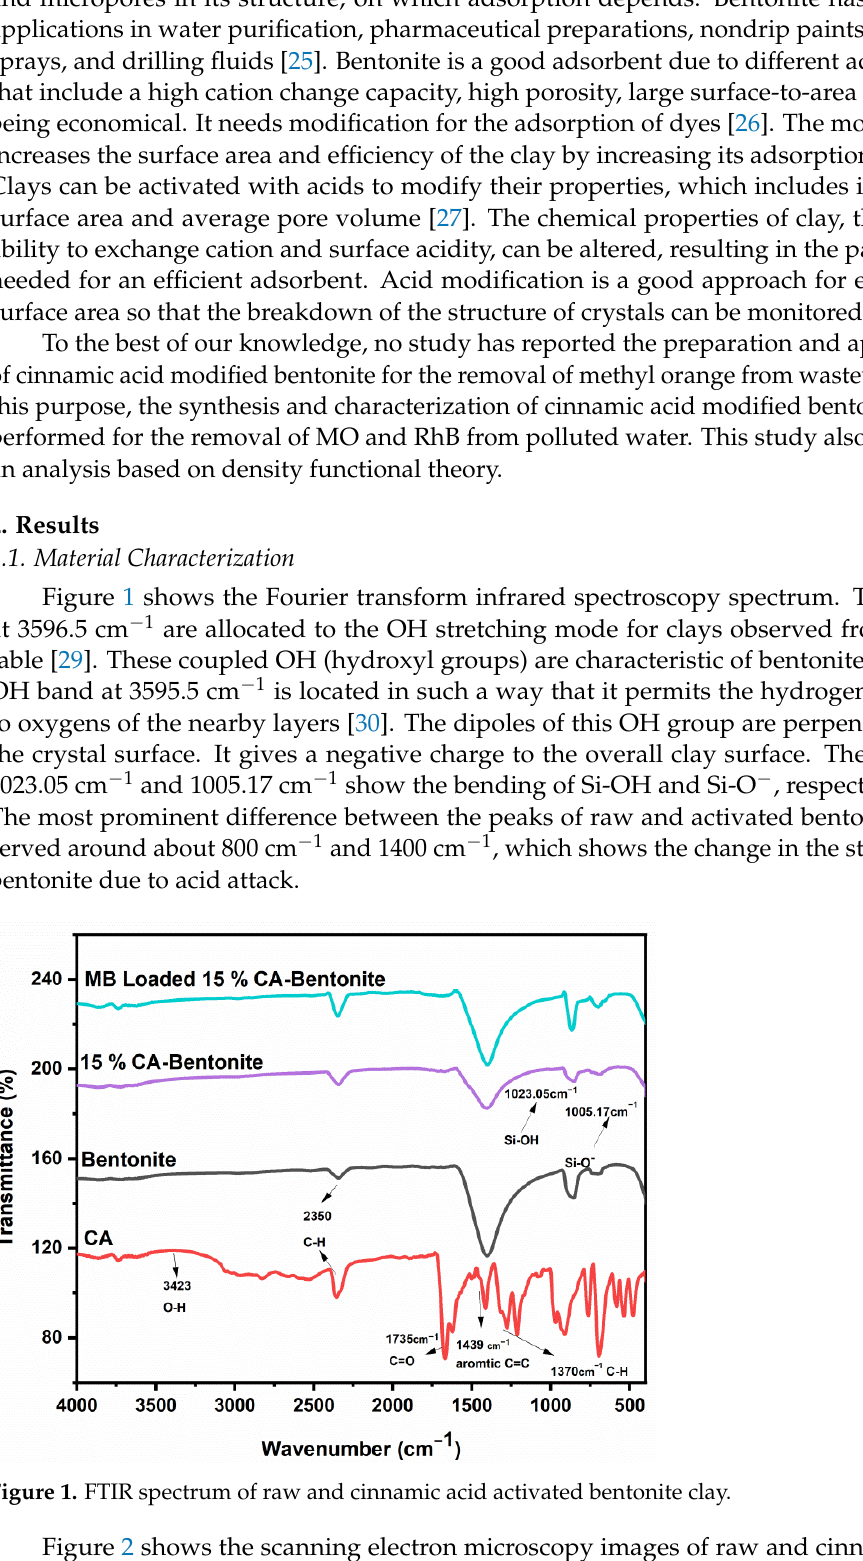
Figure 2. SEM images of ( a , b ) raw bentonite and ( c , d ) cinnamic acid modified bentonite. Figure 3 displays the XRD spectrum, which shows that the clay is highly crystalline because the peaks are narrow. The main peak at 2 θ = 28.65° is the characteristic band for quartz (SiO 2 ). Quartz is a silica polymorph that consists of interrelated tetrahedral which make a strong three ‐ dimensional network. The peaks at 2 θ = 12.41°, 44.5°, and 56.7° are characteristic of bentonite clay. Figure 3 shows that the montmorillonite section of the clay changed after acid activation at 12.41°. Furthermore, the interlayer spacing of the